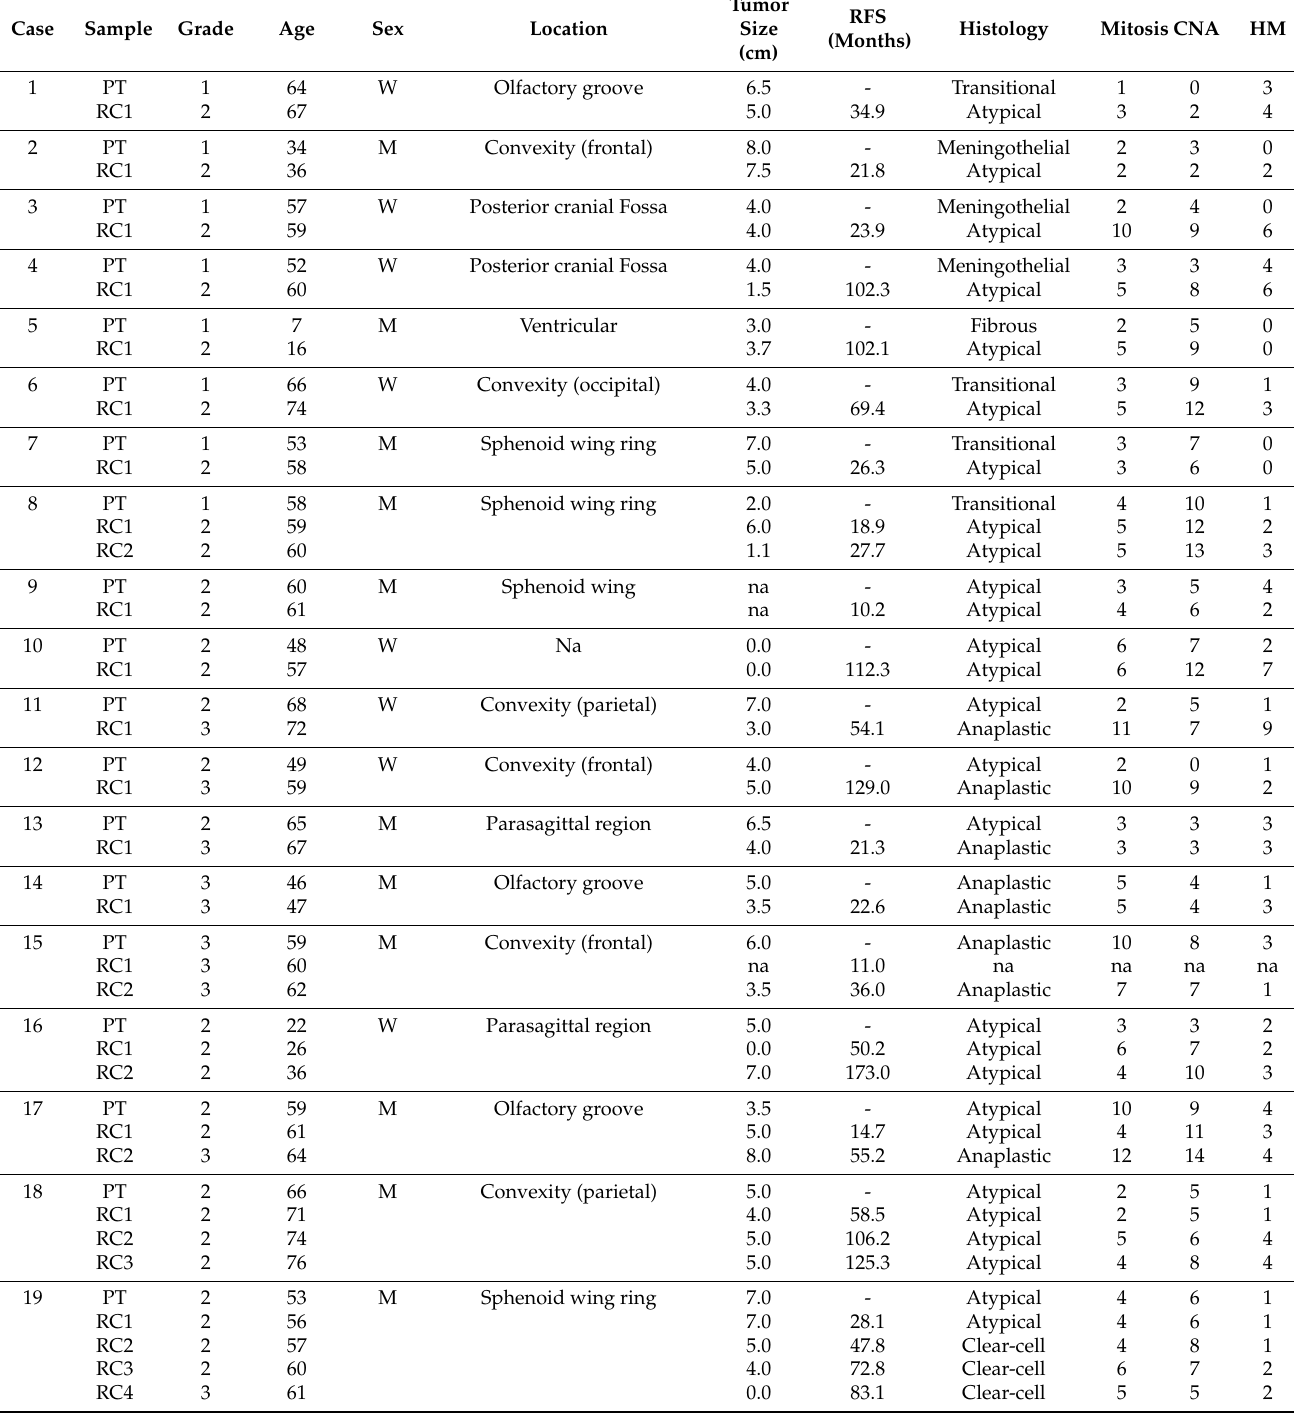
Table 1. Clinical, histopathological, and genetic